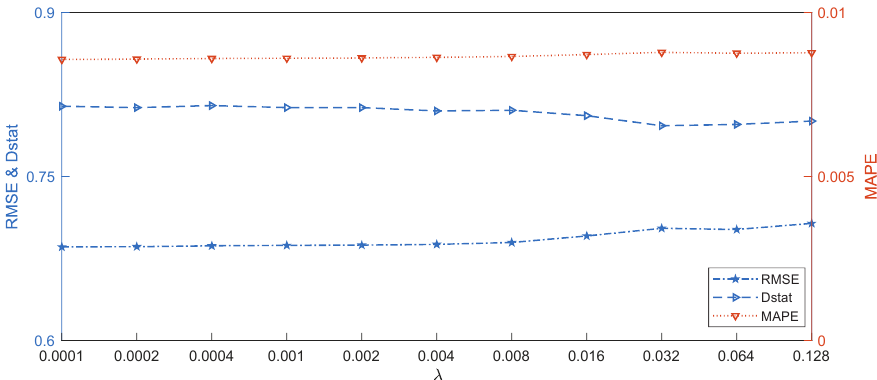
Figure 6. The impact of variable λ along with the fixed maximum number of iteration n = 600 on WTI crude oil prices with one-step-ahead